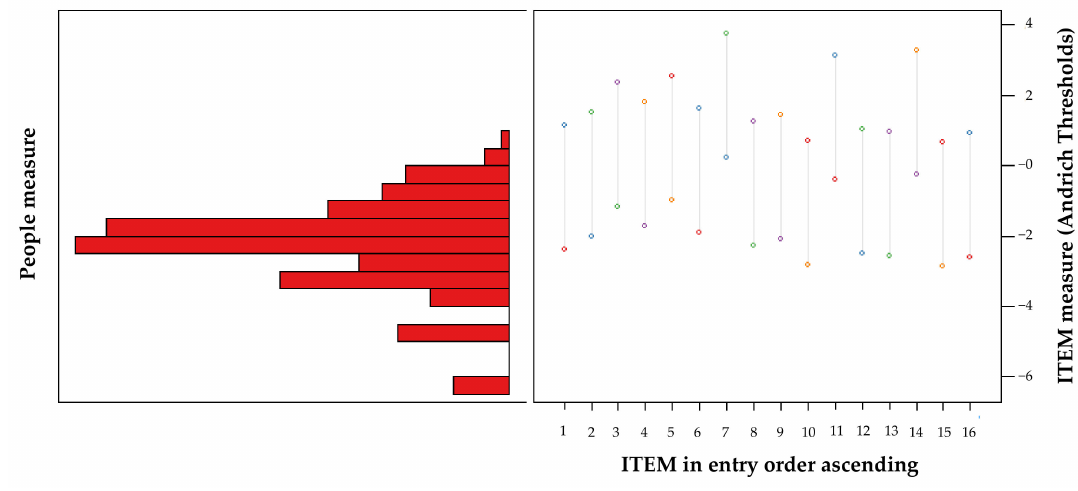
Figure 3. Item–person map for the CVS-Q